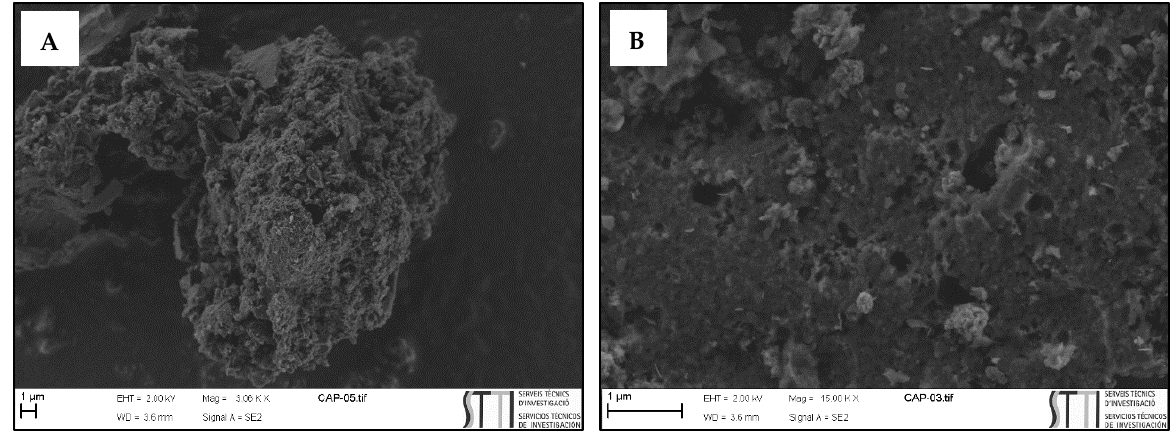
Figure 1. PULSORB PWX-HA images with scanning electron microscopy: ( A ) Mag = 3.06 K X; ( B ) Mag = 15.00 K X.